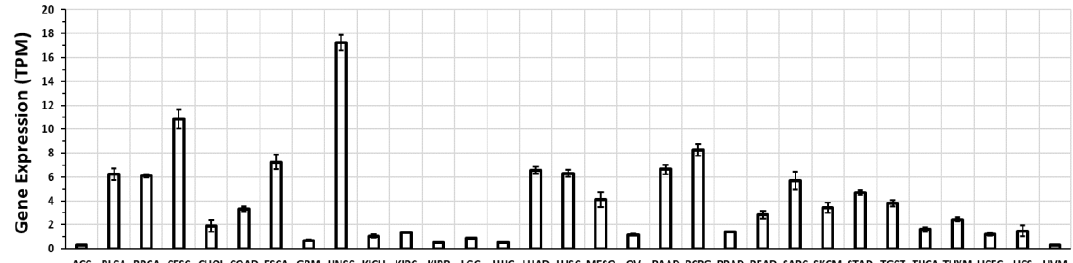
Figure 3. GPR68 expression in solid tumors. These data were generated by RNA-seq, quantified in transcripts per million (TPM) from the Cancer Genome Atlas (TCGA) database [64], re-analyzed via TOIL [34], and obtained from xena.ucsd.edu. Expression indicated are mean and standard error of the mean (SEM) in each tumor type. ACC (adrenocortical carcinoma); BLCA (bladder (uveal melanoma).